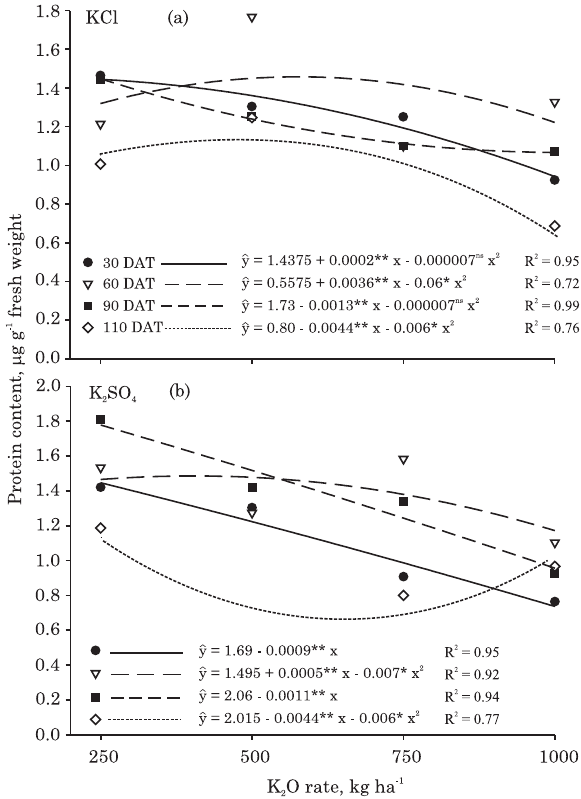
Figure 4. Effect of K sources and rates on protein content in eggplant leaves at 30, 60, 90, and 110 days after transplanting (DAT). Table 2. Effect of K sources and rates on the number of eggplant leaves